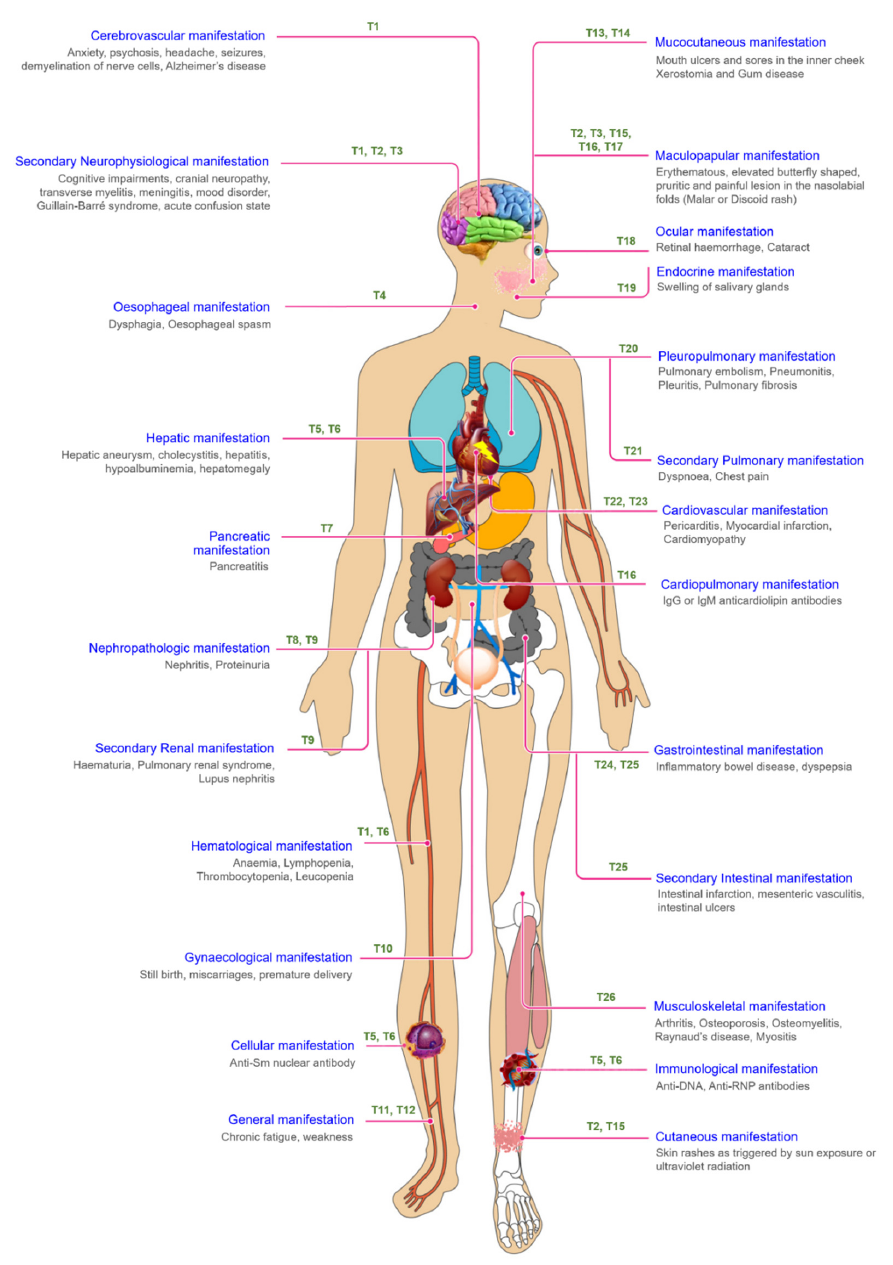
Figure 2. Clinical manifestations of systemic lupus erythromatosus along with therapeutic interventions. Systemic lupus erythromatosus is a chronic autoimmune disease targeting various systems of the human body including the cardiovascular, cerebrovascular, gastrointestinal, gynecological, hematological, hepatic, immunological, mucocutaneous, musculoskeletal, ocular, esophageal, pancreatic, pulmonary and renal systems. The treatment of SLE is centered upon formulating a regimen of topical and systemic therapies designed to reduce both disease severity and activity, wherein various treatment modalities are T1: dapsone and fingolimod; T2: lenalidomide; T3: thalidomide; T4: calcium channel blockers; T5: glucocorticoid prednisone; T6: azathioprine; T7: rifampin; T8: chaperonin 10; T9: mycophenolate mofetil; T10: misoprostol; T11: iron supplements; T12: vitamin B complex; T13: benzocaine; T14: salbutamol; T15: clofazimine; T16: IVIG (intravenous immunoglobulin); T17: cefuroxime; T18: quinacrine; T19: NSAIDs (non-steroidal anti-inflammatory drugs); T20: methylprednisolone; T21: ipatropium bromide; T22: ibuprofen; T23: aspirin; T24: corticosteroids; T25: aminosalicylate; and T26: